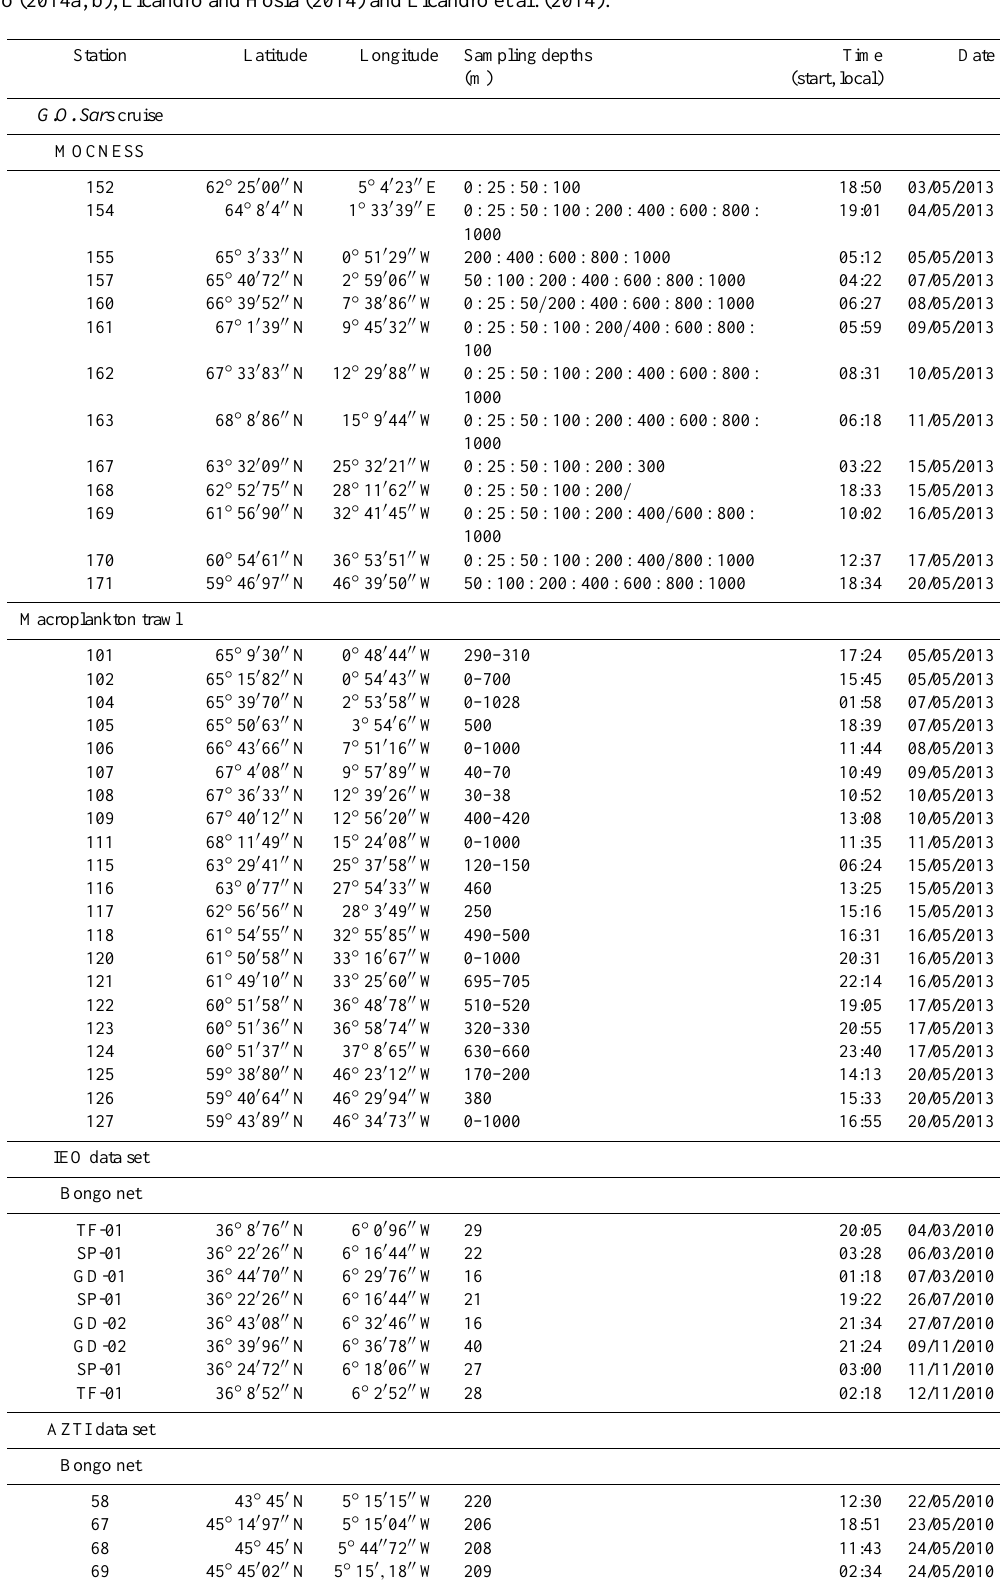
Table 3. List of stations at which jellyfish were collected using different collection gears. Main sampling information is also indicated. Data from Licandro (2014a, b), Licandro and Hosia (2014) and Licandro et al. (2014).